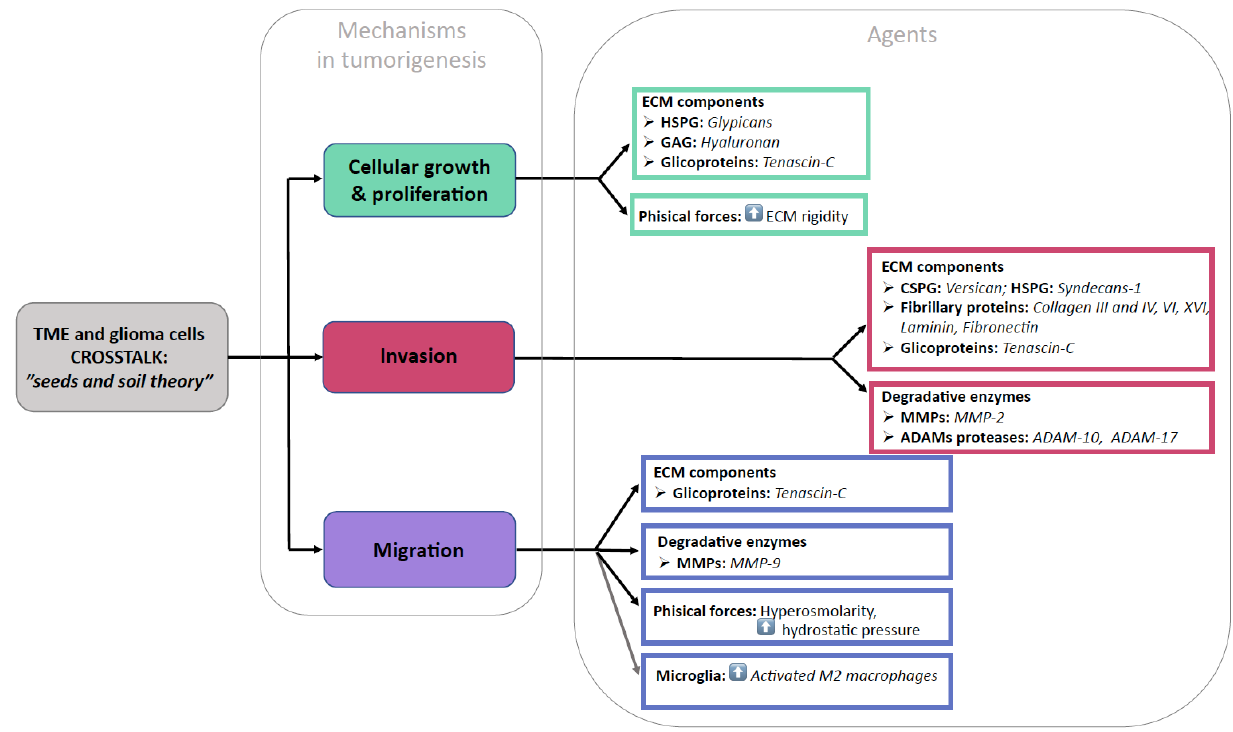
Figure 2. Pictorial summary of our findings .